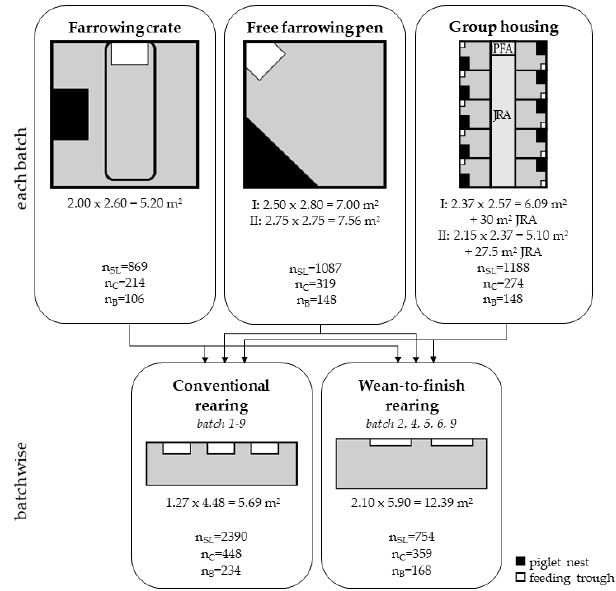
Figure 1. Schematic overview of the experimental design (n SL = number of animals scored for skin lesions; n C = number of animals sampled for serum cortisol; n B = number of animals observed for behavior; I/II: different types of pen size; PFA = piglet feeding area; JRA = joint running area).